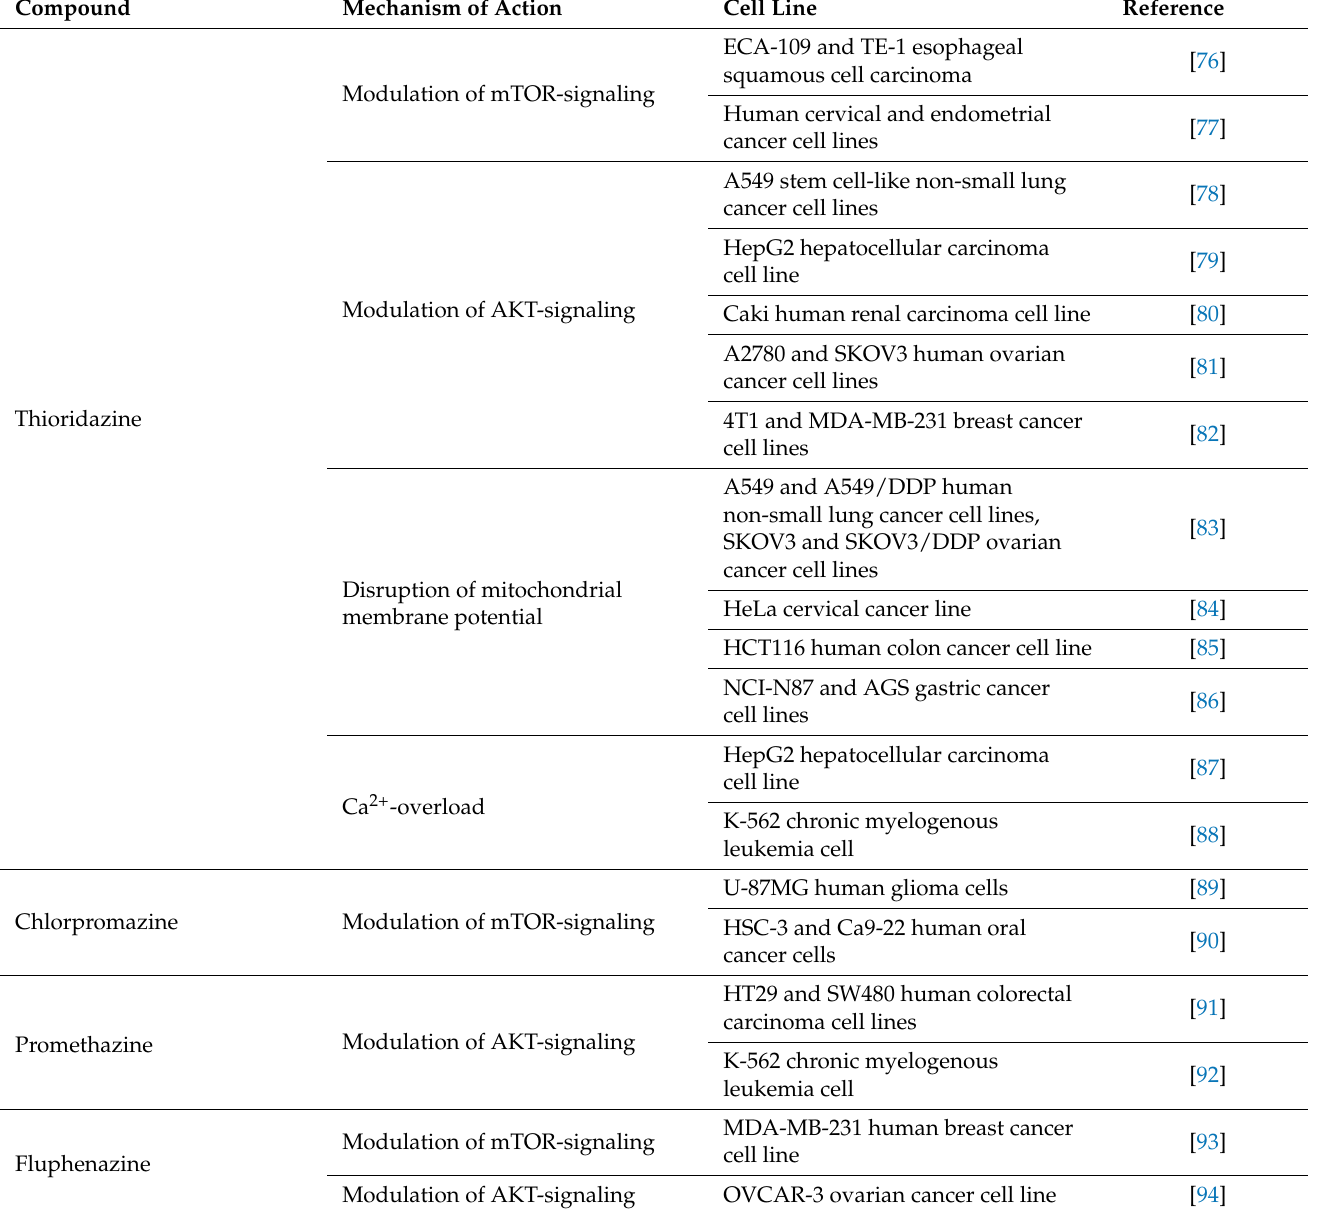
Table 3. Phenothiazines with anticancer